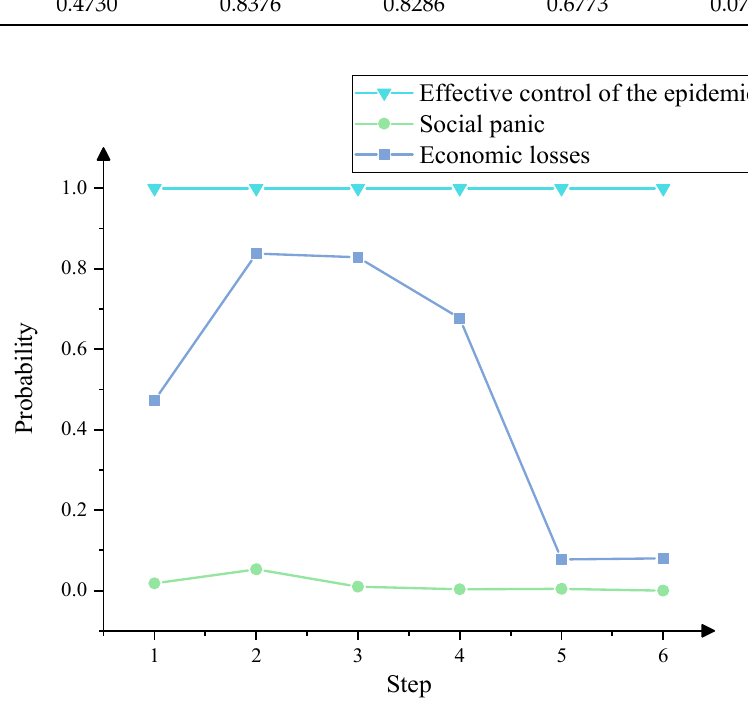
Figure 8. Prediction probabilities trend chart of resultant events.